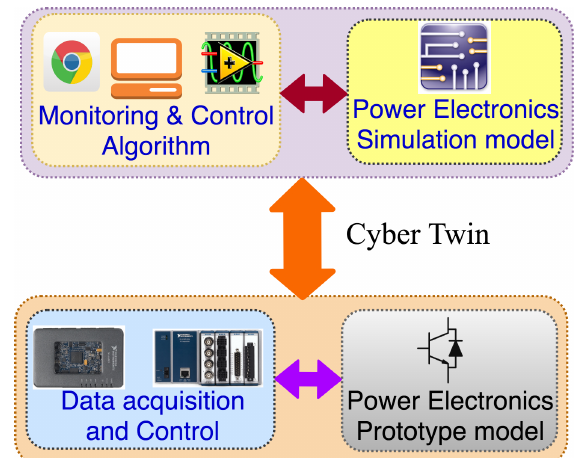
Figure 1. Block diagram of cyber twin.